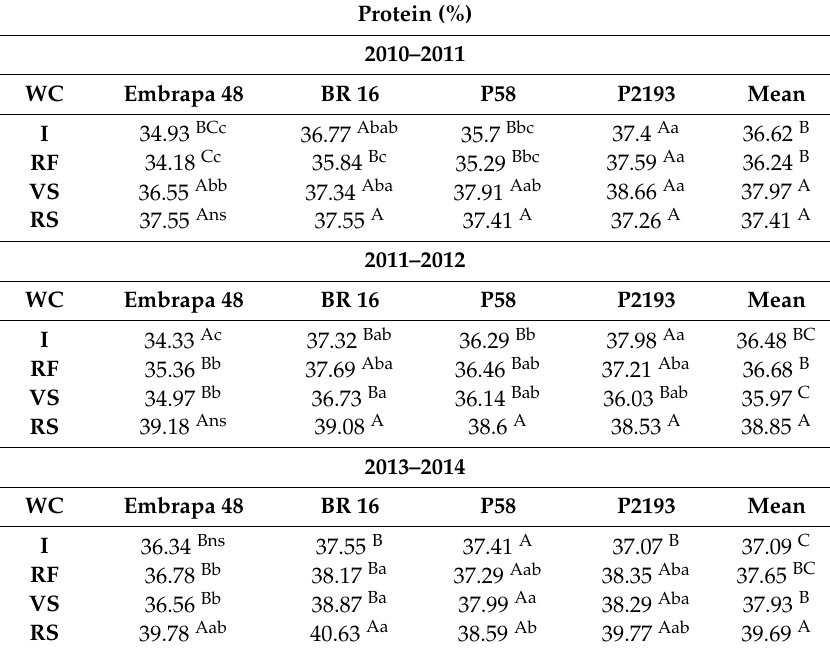
Table 4. Protein content (%) in grains on a dry basis in soybean genotypes grown under different water conditions (WC) for three crop seasons in Londrina, PR,